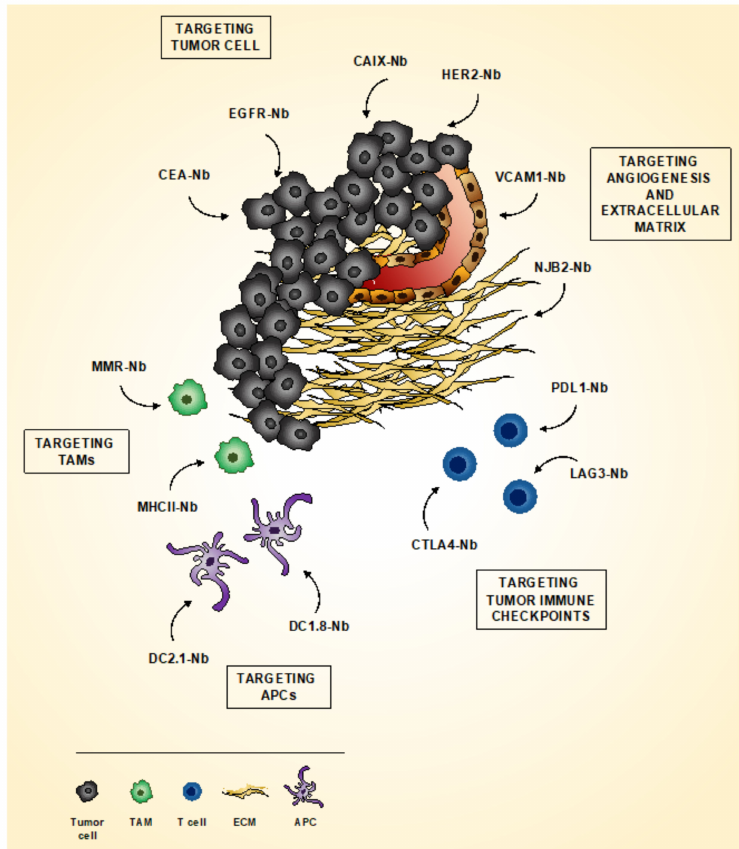
Figure 2. Imaging tumor with Nbs. In the last decades, several Nbs have been generated to detect di ff erent components and cell populations of the tumor microenvironment in vivo. Nbs directed against HER2, CAIX, EGFR and CEA have been widely used, alone or in combination to visualize neoplasticcells. Tumorangiogenesisandextracellularmatrix(ECM)compositionhavebeeninvestigated using anti-VCAM-1 and anti-NJB2 Nbs. Moreover, pro-tumorigenic tumor-associated macrophages (TAMs) have been identified by anti-MMR Nbs, while TAMs associated to anti-tumor response have been detected by anti-MHC-II Nbs. Other Nb-based probes have also been designed to target antigen presenting cells (APCs). Finally, several Nbs have been developed for immune-checkpoint inhibitor, including CTLA-4 and PD-L1. More recently, anti-LAG3 Nbs have been generated to detect tumor-infiltrating